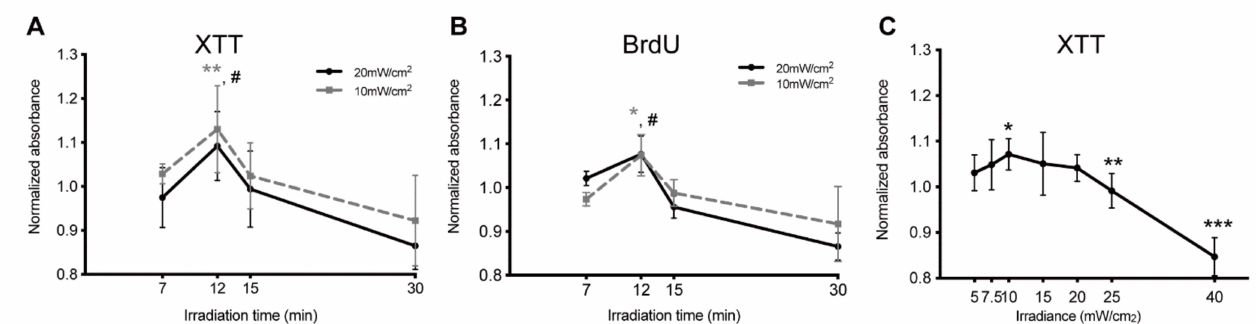
Figure 1. Blue light affects the cell viability of human umbilical vein endothelial cells (HUVECs) in a biphasic manner: ( A ) Changes in the cell viability of HUVECs following different blue light fluences with a constant time point of XTT assay at 24 h after irradiation. Absorbance was normalized to non-irradiated controls. Data are shown as mean ± SD ( n = 3 repetitions, ** p < 0.01: 10 mW/cm 2 vs. control, # p < 0.05: 20 mW/cm 2 vs. control, Student t -test). ( B ) Changes in the cell proliferation of HUVECs following different blue light fluences. BrdU assays are shown 24 h after irradiation. Absorbance was normalized to non-irradiated controls. Data are shown as mean ± SD ( n = 3 repetitions, * p < 0.05: 10 mW/cm 2 vs. control, # p < 0.05: 20 mW/cm 2 vs. control, Student t -test). ( C ) Changes in the cell viability of HUVECs following different blue light fluences with a constant irradiance and fixed time point 12 min of XTT assay at 24 h after irradiation. Absorbance was normalized to non-irradiated controls. Data are shown as mean ± SD ( n = 3 repetitions, * p < 0.05, ** p < 0.01, *** p < 0.001 vs. control, Student t